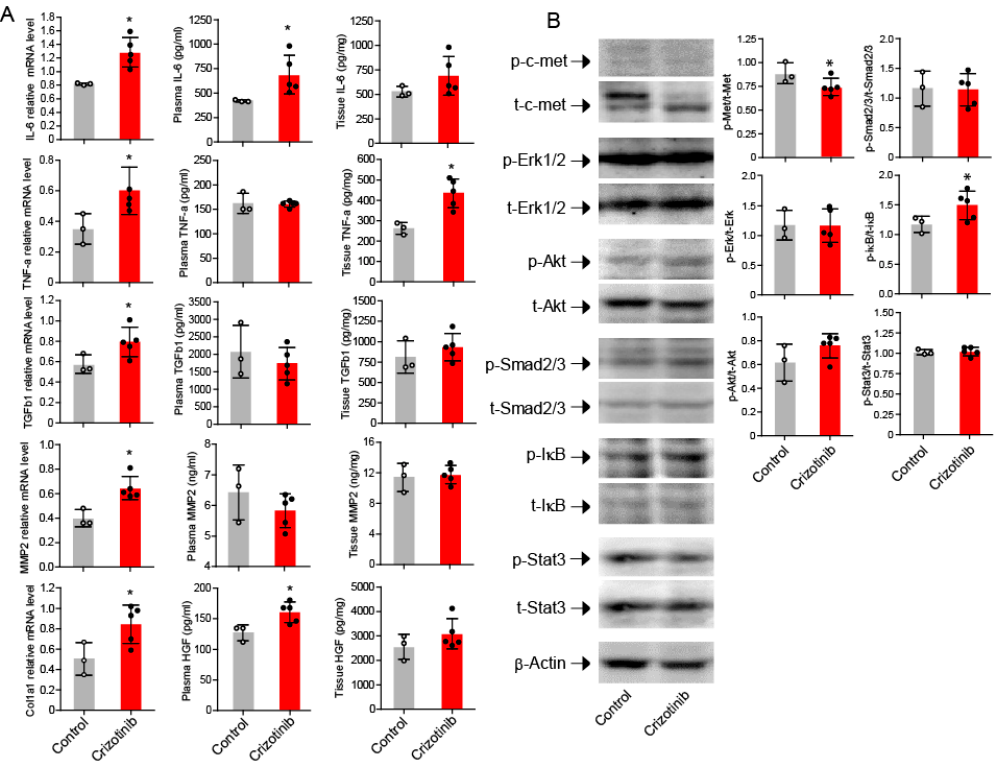
Figure 4. Cytokines, proteases and signal pathways after crizotinib administration. Increased mRNA expression of Col1a1, TGF β 1, IL-6, TNF α , and MMP2 in mice treated with crizotinib compared to untreated mice ( A ). Significant difference in phosphorylation level of c-Met and I κ B between mice treated with and without crizotinib ( B ). Data are mean ± SD. Control group n = 3; crizotinib group n = 5. * p < 0.05 versus control group.